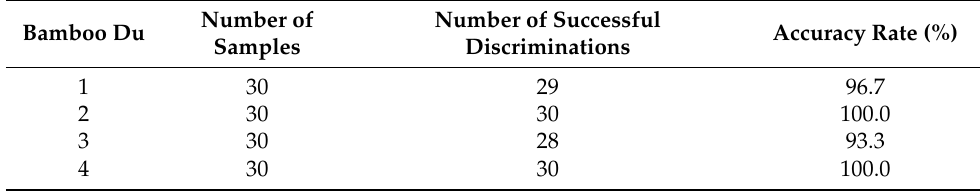
Table 5. Validation results of the proposed bamboo du determination method. Bamboo